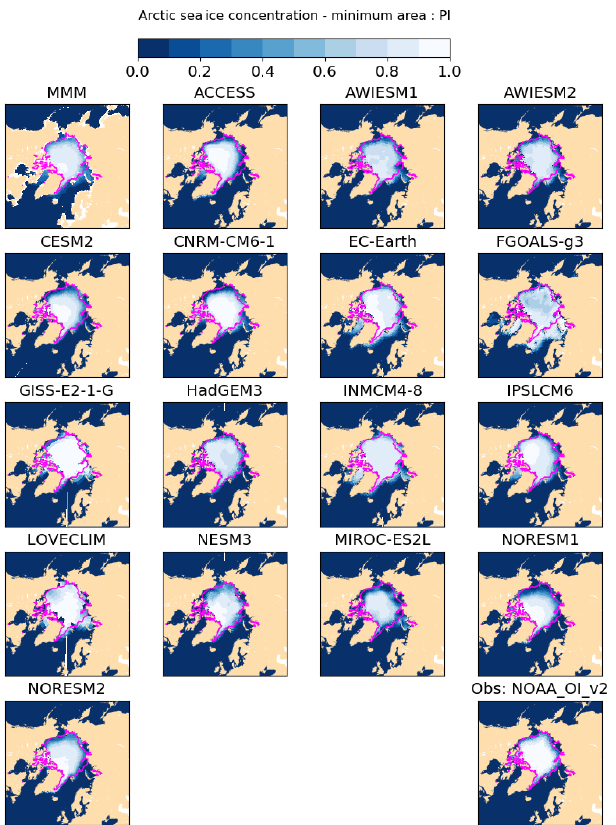
Figure 4. Sea ice annual concentration simulated for PI, for the multi-model mean (MMM) and for each model. The colour filling of the symbols on the maps correspond to the observed values at each site, which are classified into three categories according to the NOAA_OI_v2 dataset: perennial cover (9 to 12 months), sea- sonal cover (3 to 9 months) and ice-free state (0 to 3 months). On the MMM panel, for each data site the colour of the symbol out- line corresponds to the number of models simulating the observed ice cover. On the panels for individual models, the shape of the symbol depends on the observed result being below the simulated one (triangle down), above the simulated one (triangle up) or in the same category as the simulated one (circle). The number of sites for which reconstructions are equal to and above the number of months simulated by models are written at the bottom-right corner of each